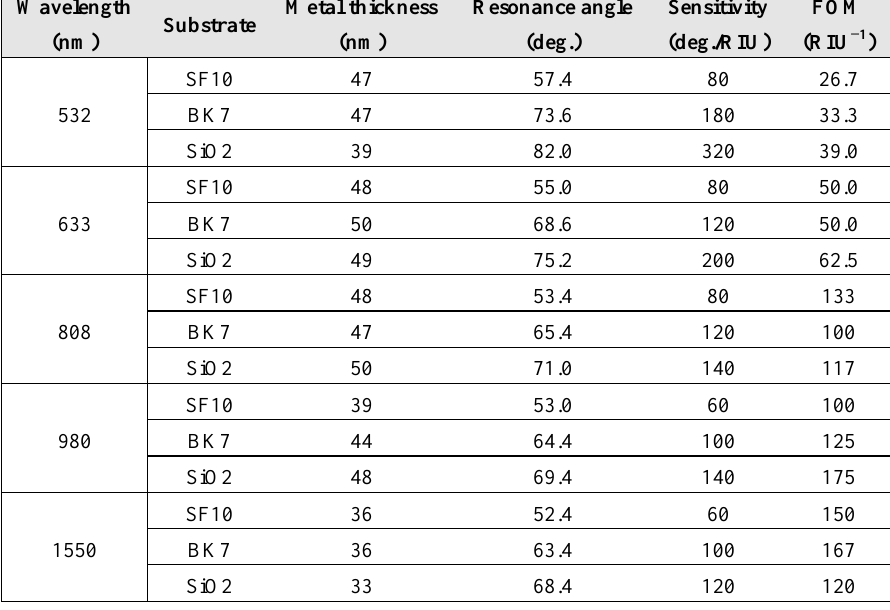
Table A. Optimal characteristics of a Kretschmann configuration-based sensor with an Ag